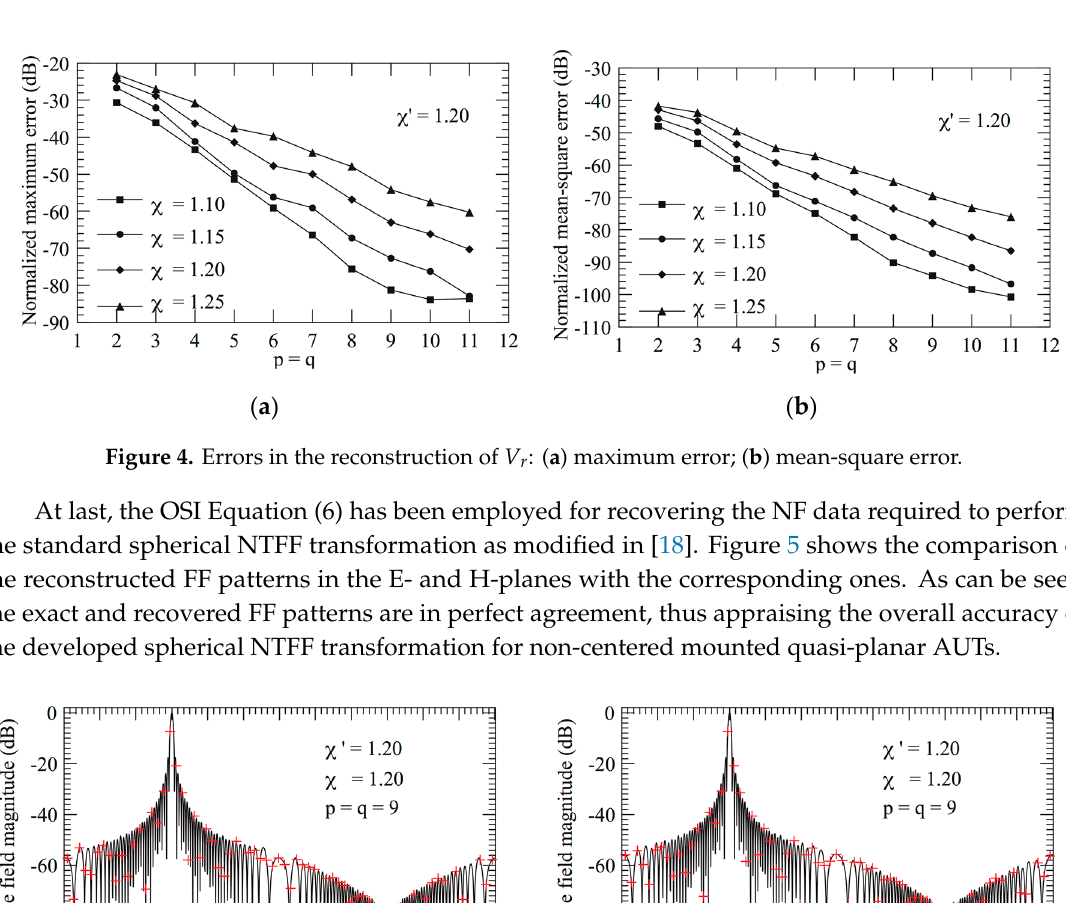
Figure 5. Far-field pattern. ――― exact. + + + + interpolated from the non-redundant samples: ( a ) E-plane; ( b ) H-plane.